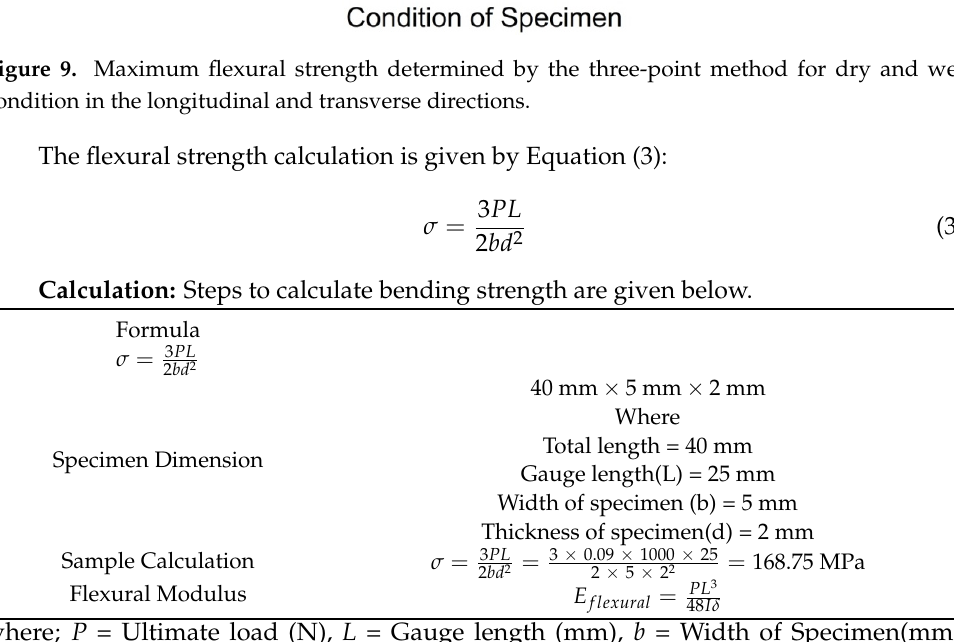
Figure 9. Maximum flexural strength determined by the three-point method for dry and wet condi- tion in the longitudinal and transverse